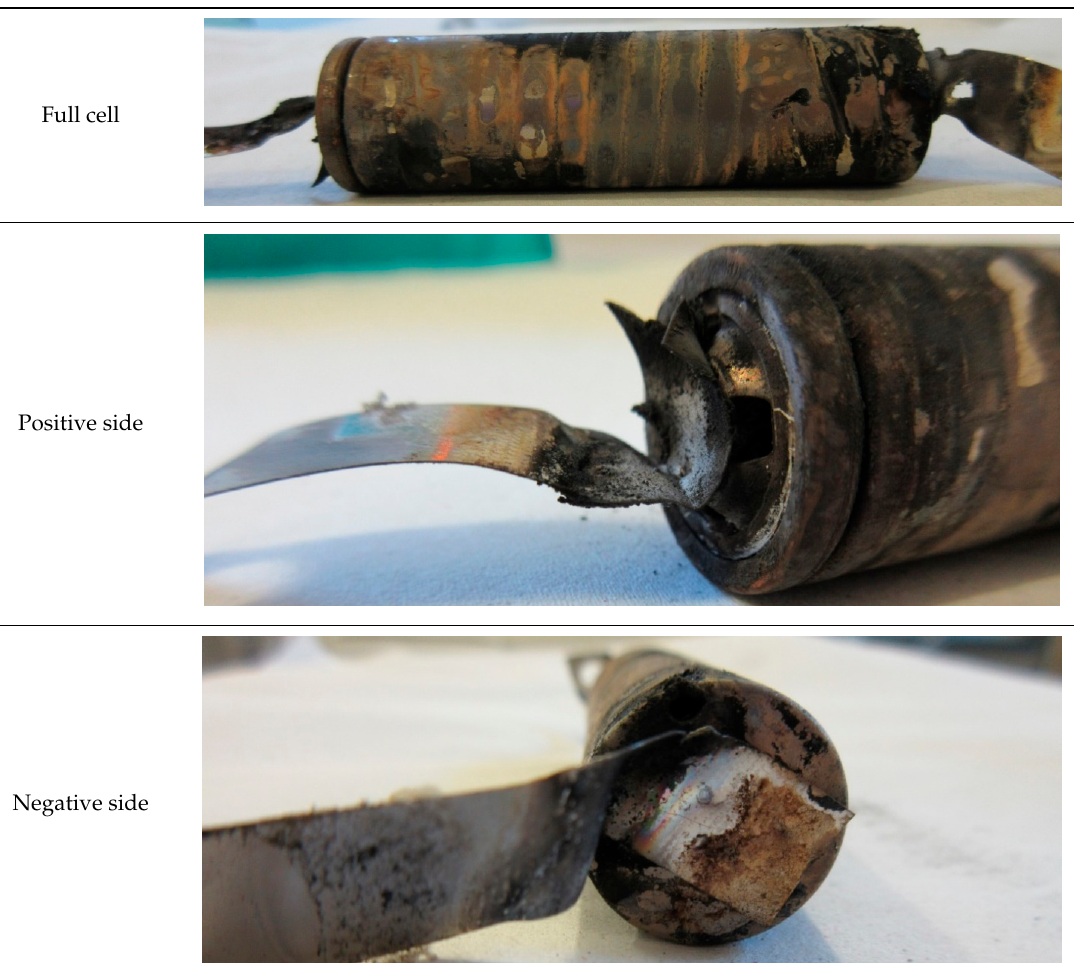
Table A1. Thermally abused LG HG2 at 100% SOC.